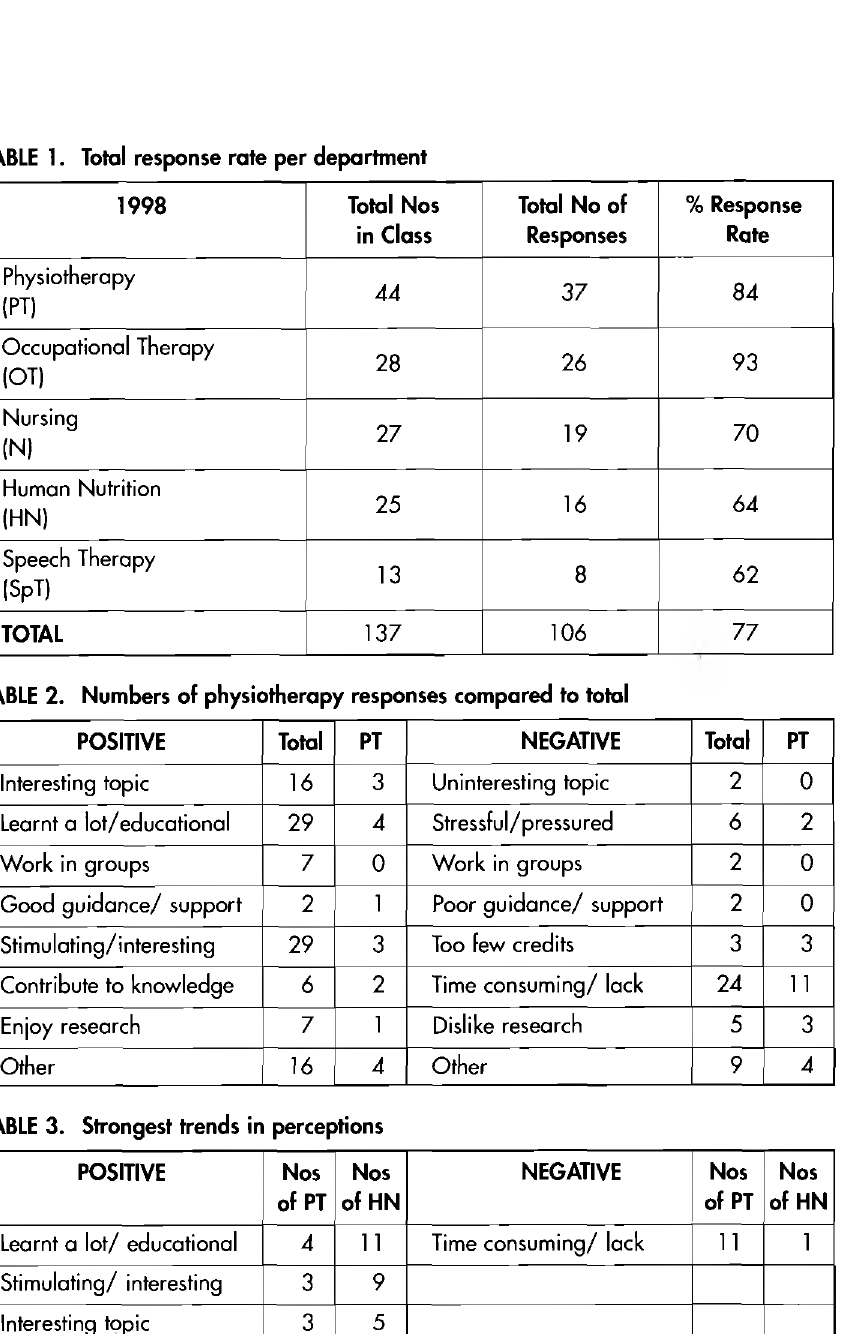
TABLE 3. Strongest trends in